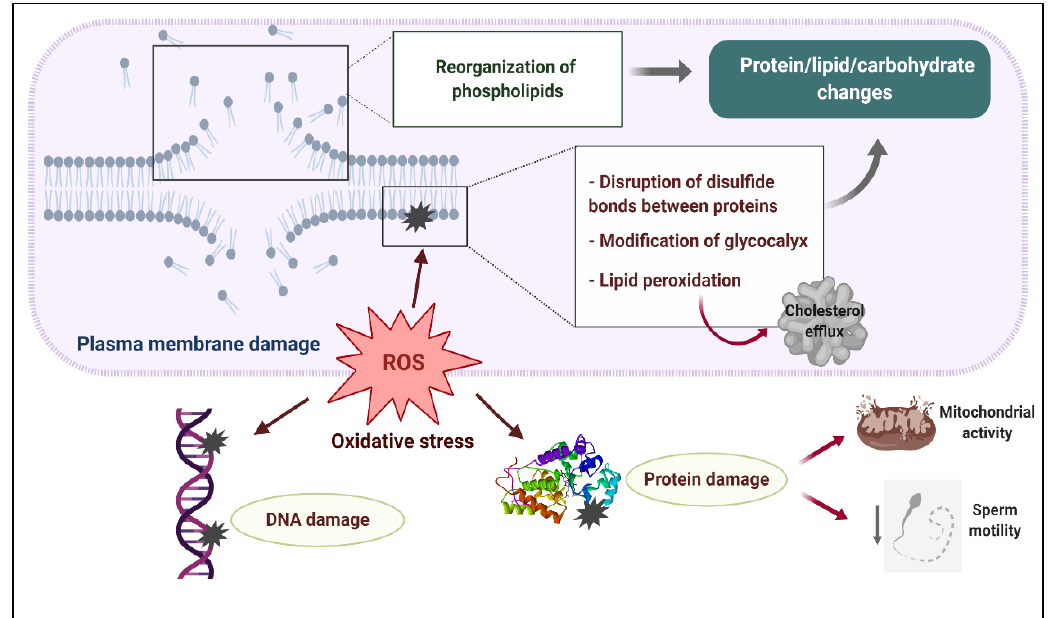
Figure 2. Plasma membrane damage during sperm cryopreservation and its relationship with oxidative stress. A reorganization of sperm membrane phospholipids takes places during freezing–thawing, altering lipid–protein, lipid–carbohydrate and protein–carbohydrate interactions which are necessary for proper membrane activity. Excessive production of reactive oxygen species (ROS) leads to major protein, lipid and carbohydrate changes in the sperm membrane due to the reduction of disulfide bonds between membrane proteins, peroxidation of membrane phospholipids and modifications of the sperm glycocalyx. As a result, the sperm membrane becomes fragile and its semipermeable property is lost. Overproduction of ROS during sperm cryopreservation may also cause DNA damage and impair several axonemal and mitochondrial proteins, which negatively affect mitochondrial activity and axonemal integrity, resulting in the loss of sperm motility.